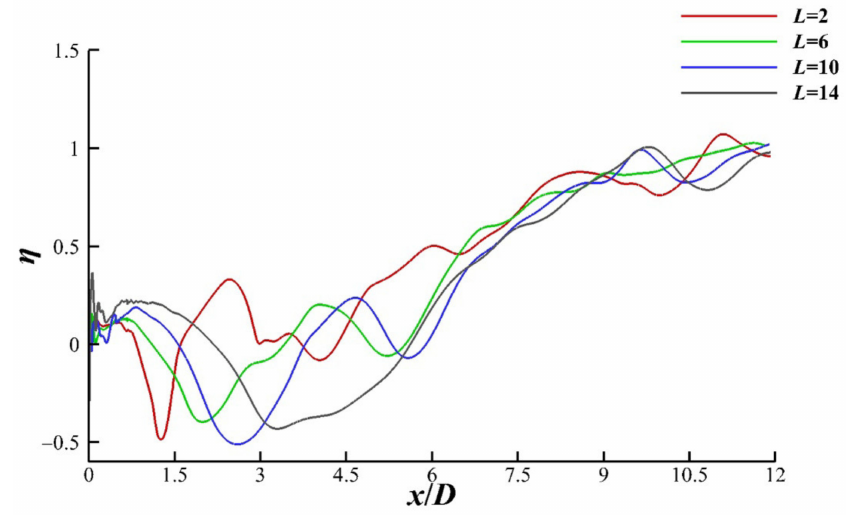
Figure 17. Velocity radial deficit at four positions: ( a ) x = 4D, ( b ) x = 6.5D, ( c ) x = 9D, and ( d ) x = 11.5D.